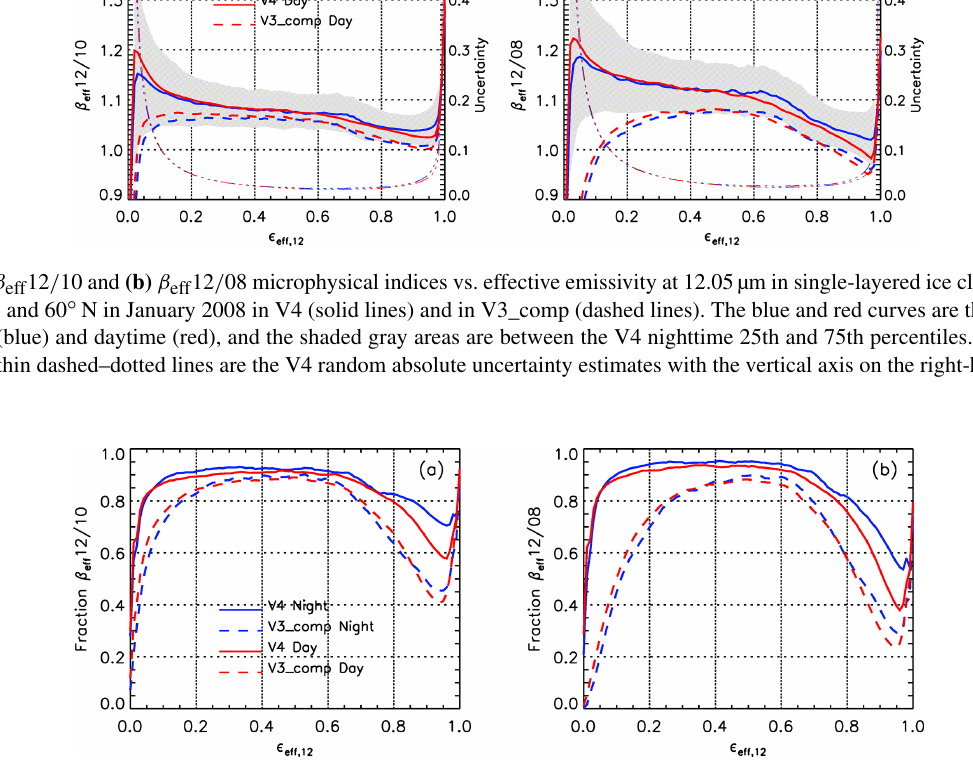
Figure 6. Fraction of (a) β eff 12 / 10 and (b) β eff 12 / 08 values above the effective diameter retrieval sensitivity limit vs. effective emissivity at 12.05µm in single-layered ice clouds over oceans between 60 ◦ S and 60 ◦ N in January 2008 in V4 (solid lines) and in V3_comp (dashed lines) during night (blue) and day